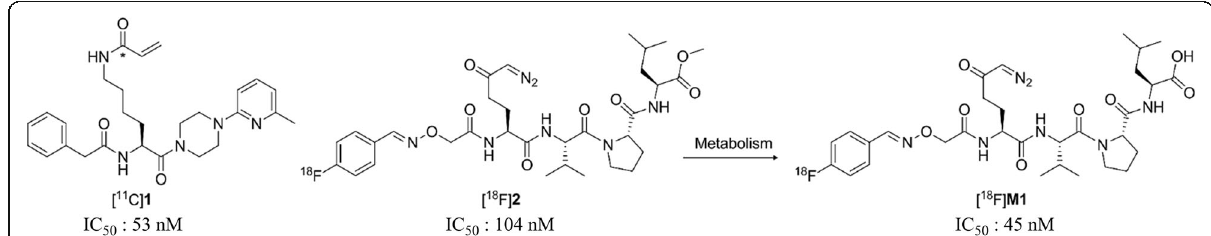
Fig. 1 Chemical structures and IC 50 values of the TG2 inhibitors [ 11 C] 1 , [ 18 F] 2 , together with that of its in vivo formed metabolite [ 18 F] M1 [19, 20]. The position of the carbon-11 label in [ 11 C] 1 is depicted by an